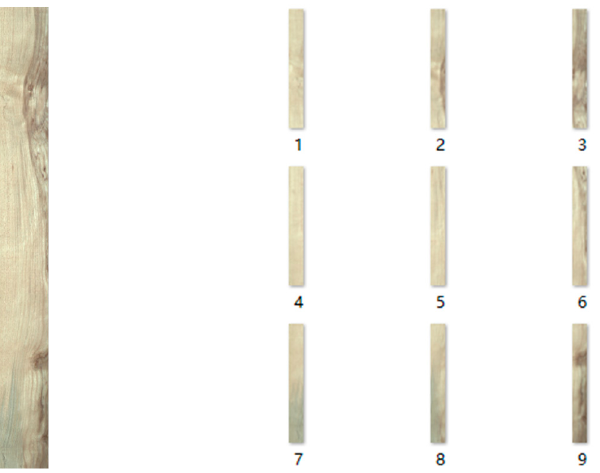
Figure 4. Original image and divided graph.